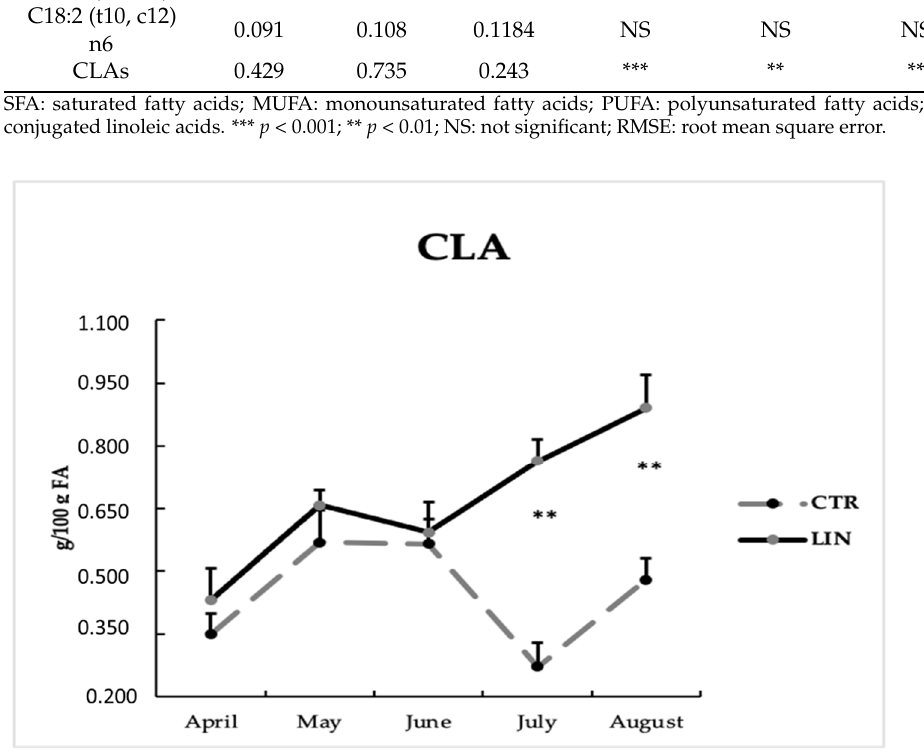
Figure 3. Goats’ CLAs during the experimental period (mean ± SD) of control (CTR) and linseed supplementation (LIN) groups. FA: fatty acids; CLA: conjugated linoleic acids. ** p < 0.01. Odd- and branched-chain fatty acid content is reported in Table 4. The total OBCFA was significantly affected by dietary treatment ( p < 0.001; 3.21 vs. 2.84 g/100 g of total FA for CTR and LIN group, respectively) and an opposite trend was seen for iso C13:0 (0.028 vs. 0.034 for CTR and LIN group, respectively, p < 0.001). Table 4. Goats’ odd- and branched-chain fatty acid content (mean value, g/100 g of total fatty acids) of control (CTR) and linseed supplementation (LIN) groups.